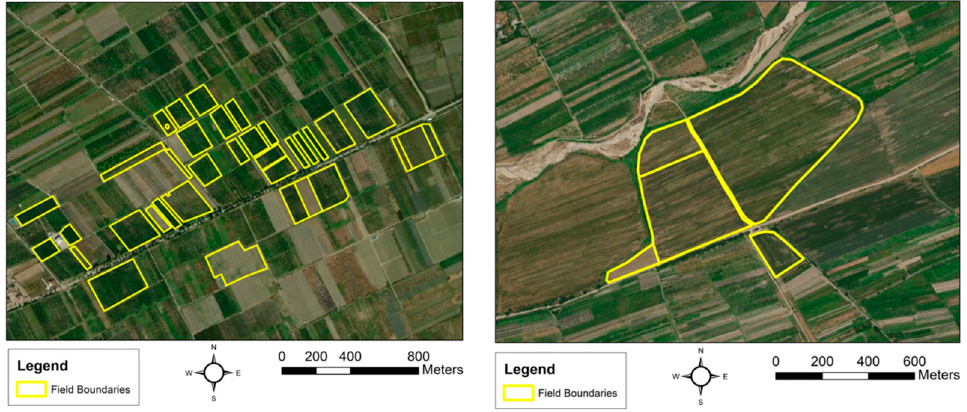
Figure 2. An example of the field boundaries’ layer, generated from topographical measurements in Khachmaz region, prior to the start of the cultivation season.